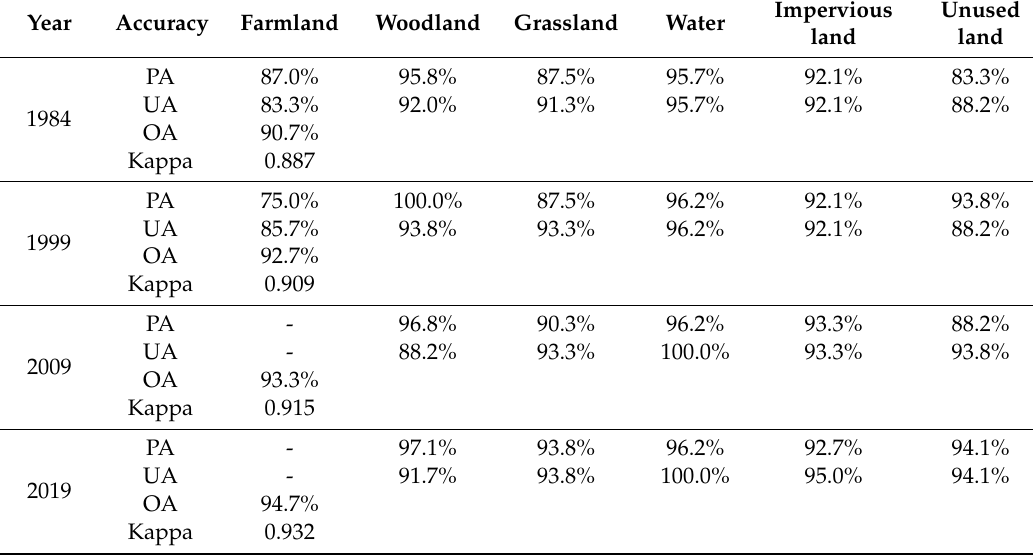
Table 2. Summary of producer’s accuracy (PA), user’s accuracy (UA), overall accuracy (OA), and kappa for land use classification of 1984, 1999, 2009, and